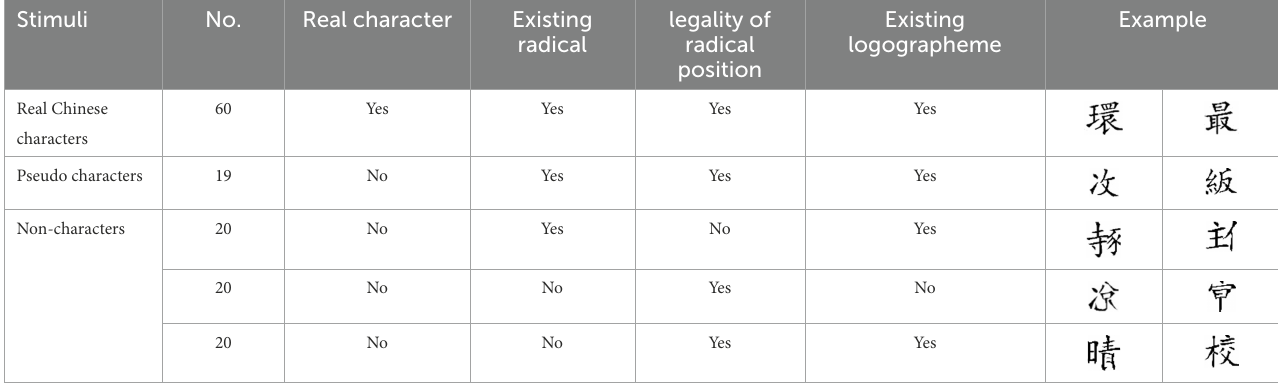
TABLE 2 Features and examples of stimuli in the orthographic awareness test.